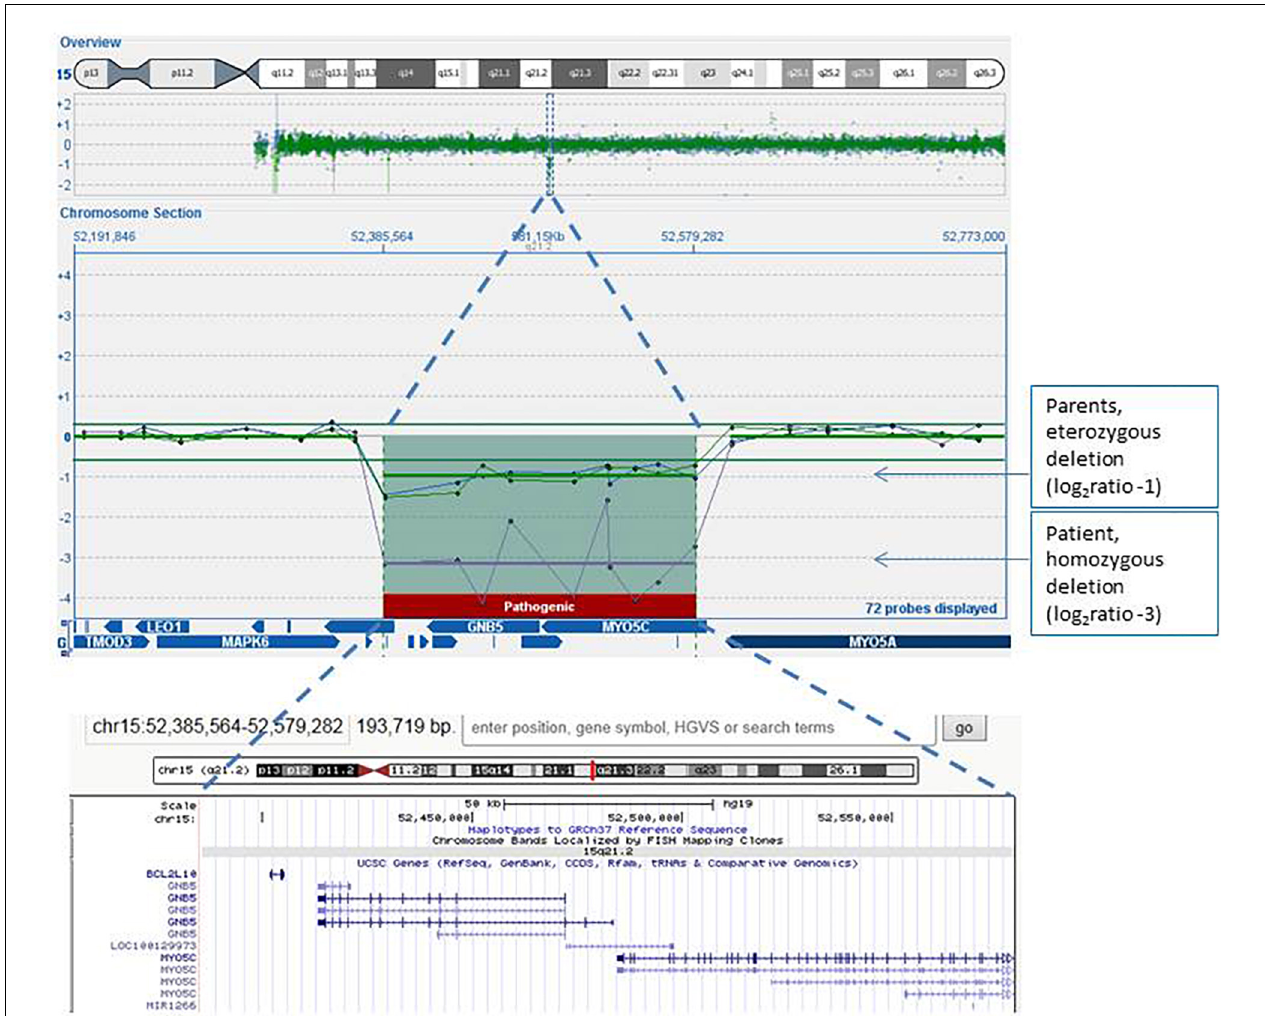
FIGURE 1 | Array-CGH genomic profile (screenshot from the Cytosure software analyses) focused on the 15q21.2 chromosome region of the proband (purple line), his mother (green line), and his father (blue line). The log2 ratio of microdeletion of the patient was about − 3, indicating homozygous deletion, while log2 ratios of the microdeletion carried by both parents were − 1, indicating heterozygous loss of the region. Also indicated in the software figure is the gene content of the region: the same region with its gene content is also enlarged in the lower image, captured in the UCSC genome browser.